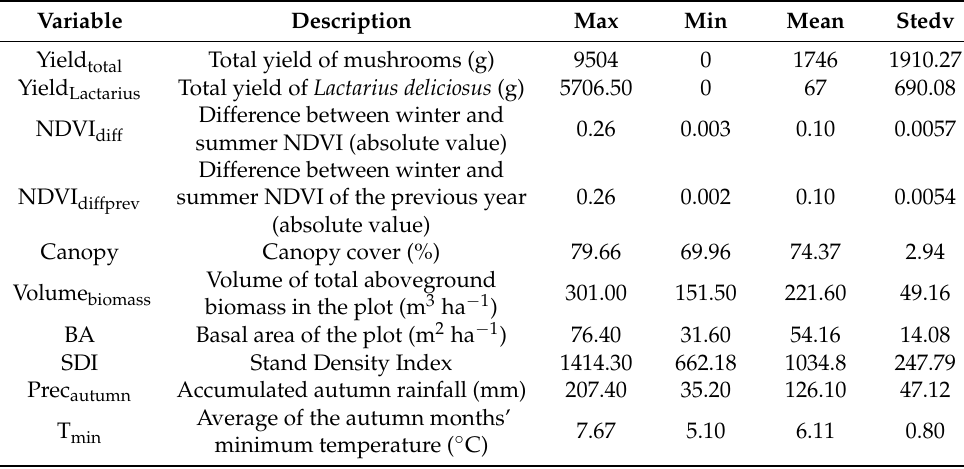
Table 1. Description of variables involved in the statistical